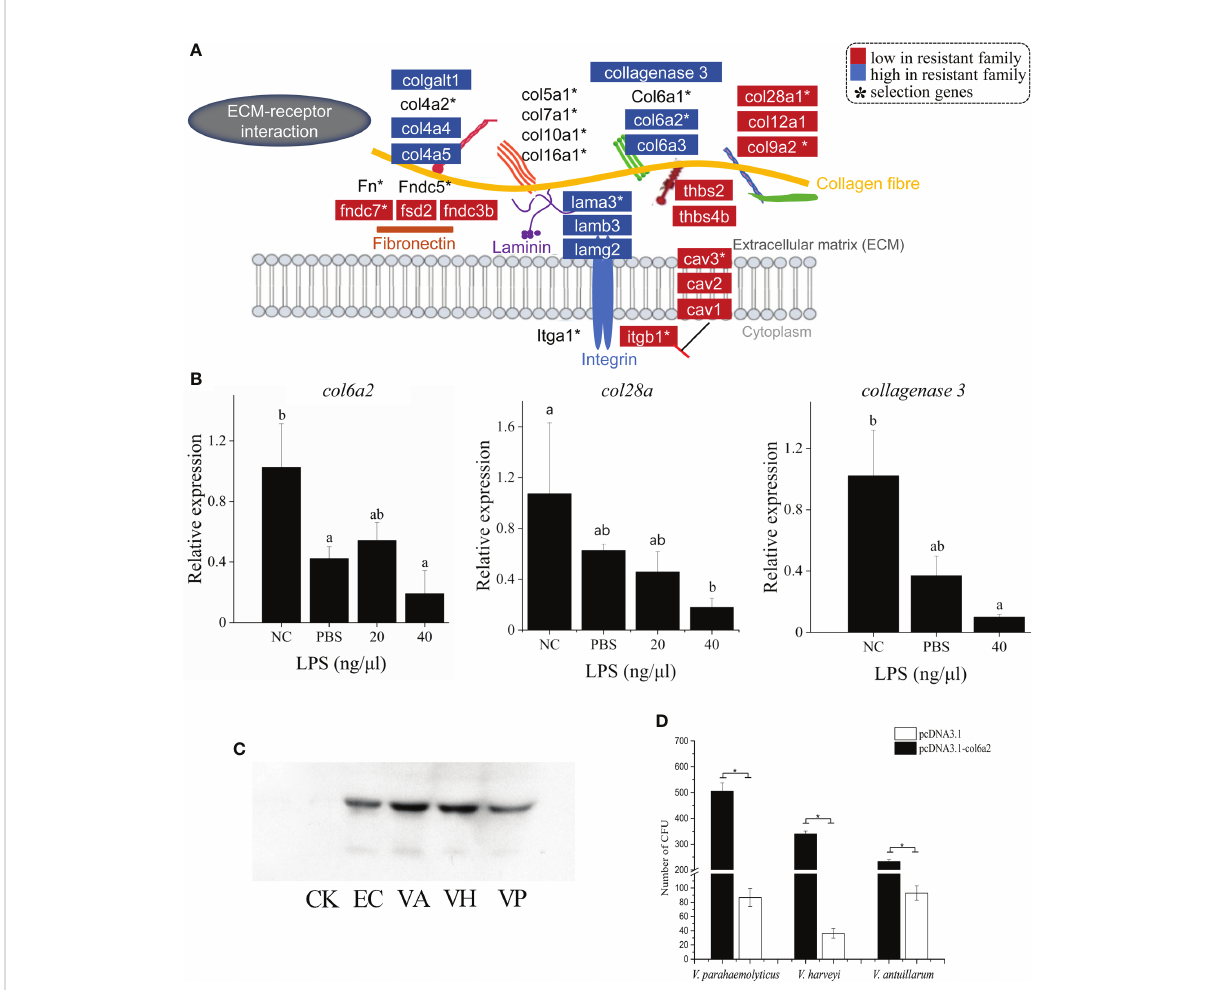
FIGURE 4 ECM-receptor interaction has strong associations with vibriosis resistance and identi fi cation of Col6a2 as a Vibrio receptor for C. semilaevis . (A) Schematic of the genetic and transcriptomic divergence in ECM-receptor interaction. Red and blue colors indicate the lower and higher expressed genes in the resistant family compared to susceptible family ( p < 0.05). * indicates the genes under selective sweeps. (B) Relative expressions of col6a2 , col28a and collagenase 3 gene in skin and kidney cells after LPS stimulation. Cells were treated with 20 and 40 ng/ m L LPS at 28°C for 2h. The alphabets a, b and c indicate signi fi cantly different expressions among the samples (P < 0.05). (C) Western Blot analysis showed that Col6a2 binds to three Vibrio pathogens, including V. anguillarum, ( VA ); V. harveyi, ( VH ); V. parahaemolyticus, ( VP ); E. coli (EC) and control (CK). (D) Transfections of HEK293T cells with col6a2 enhanced the Vibrio adhesions. * indicate signi fi cant differences ( p < 0.05) of the transfected versus untransfected cells using one-way